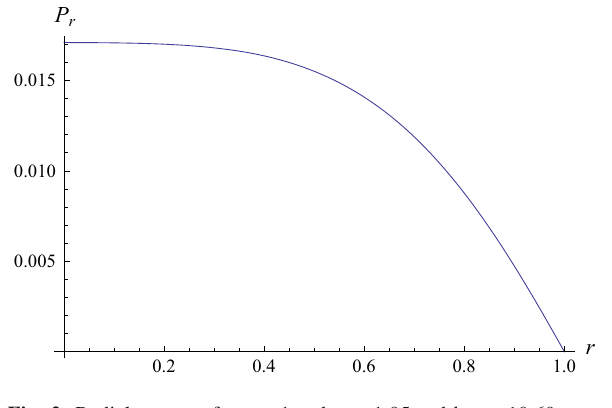
Fig. 2 Radial pressure for r = 1 and α = 1 . 95 and b = − 10 . 69